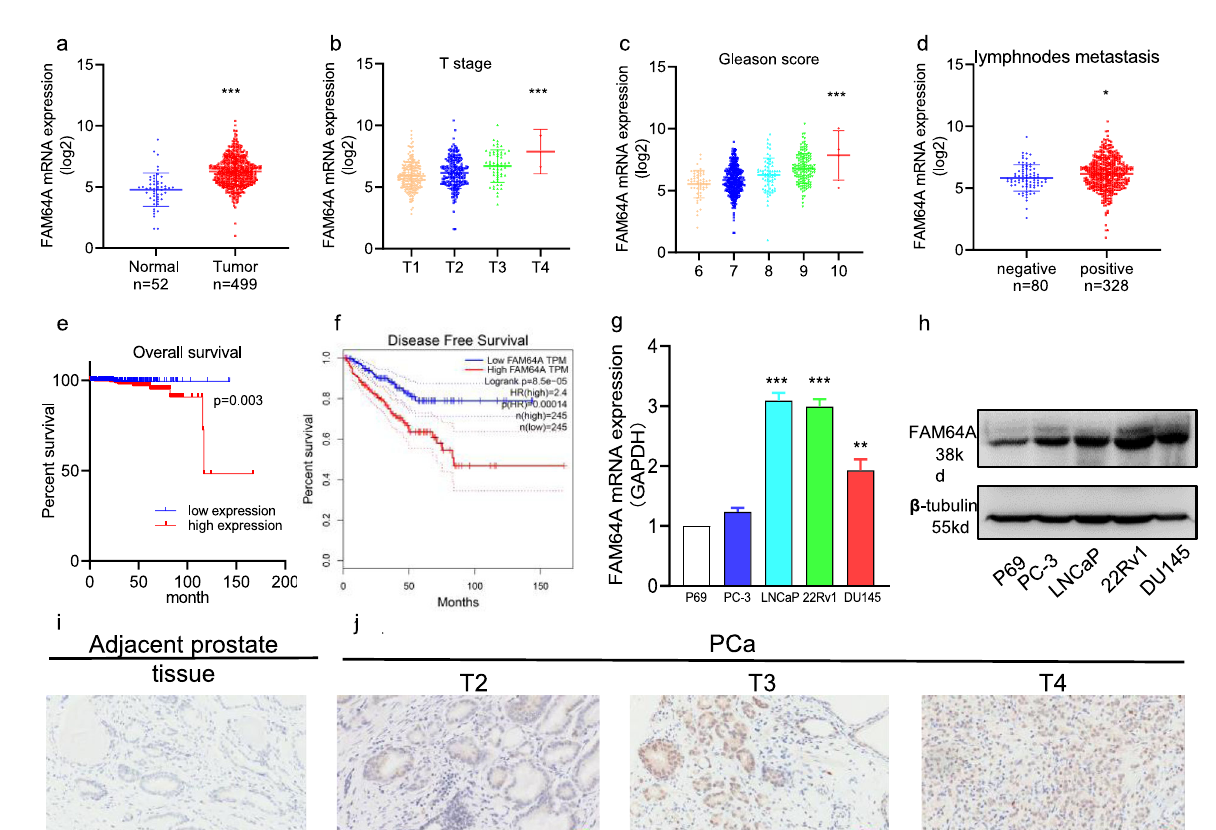
Fig. 1 FAM64A is upregulated in prostate cancer tissues and cell lines. a The expression of FAM64A in PCa tissues was signi fi cantly higher than that in normal prostate tissues by TCGA. b – d The expression of FAM64 mRNA was related to the T grade, Gleason score, and lymph nodes metastasis. e , f The lower expression level of FAM64A led to longer overall survival time and disease-free survival time. g , h FAM64A was remarkably increased in PCa cell lines PC-3, LNCaP, 22Rv1, and DU145 compared to P69 at both transcription and translation levels. i, j The expression of FAM64A protein in PCa was higher than that in adjacent normal PCa tissues and was related to the Tumor stage by immunohistochemistry staining. Scale bar = 20.25 μ m. * P < 0.05, ** P < 0.01, *** P <